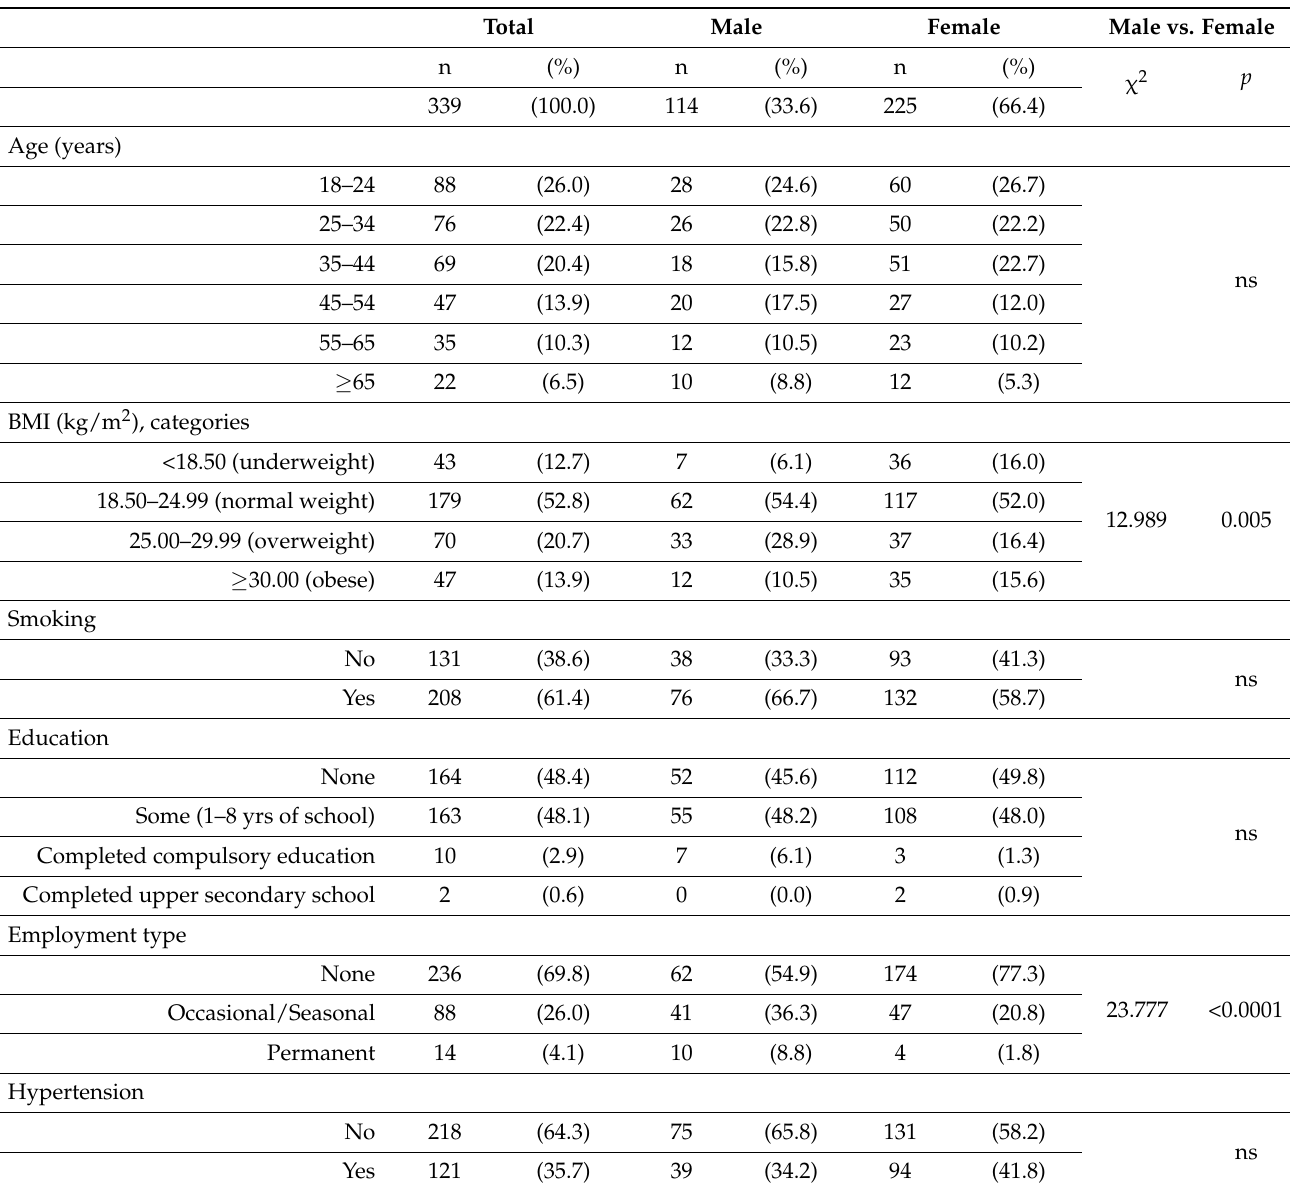
Table 2. Demographic, socio-economic, and health-related characteristics of the Ukrainian Roma population with sex differences.